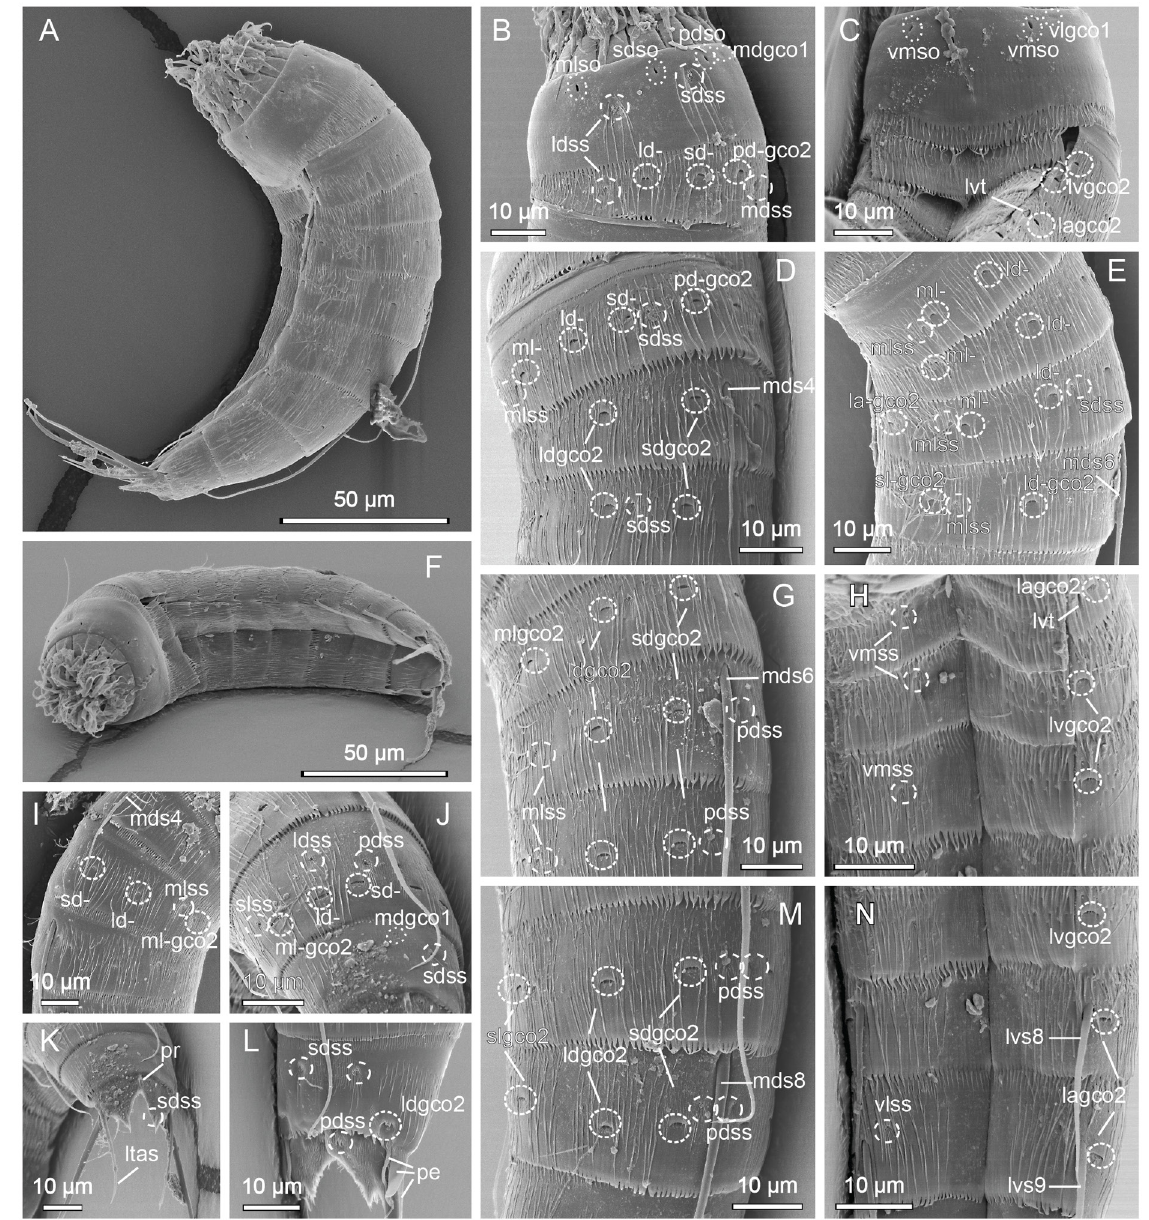
Fig. 28. Scanning electron micrographs showing overviews and details of Echinoderes aragorni sp. nov. A . Lateral overview. B . Segments 1 to 2, dorsolateral view. C . Segments 1 to 5, ventral view. D . Segments 3 to 5, dorsolateral view. E . Segments 3 to 6, lateral view. F . Ventral overview. G . Segments 5 to 7, dorsolateral view. H . Segments 5 to 7, ventral view. I . Segments 4 to 6 of male, dorsolateral view. J . Segments 9 to 10, dorsal view. K . Segments 10 to 11 of female, dorsal view. L . Segments 10 to 11 of male, dorsal view. M . Segments 7 to 8, dorsolateral view. N . Segments 7 to 9, ventral view. Abbreviations: see Material and